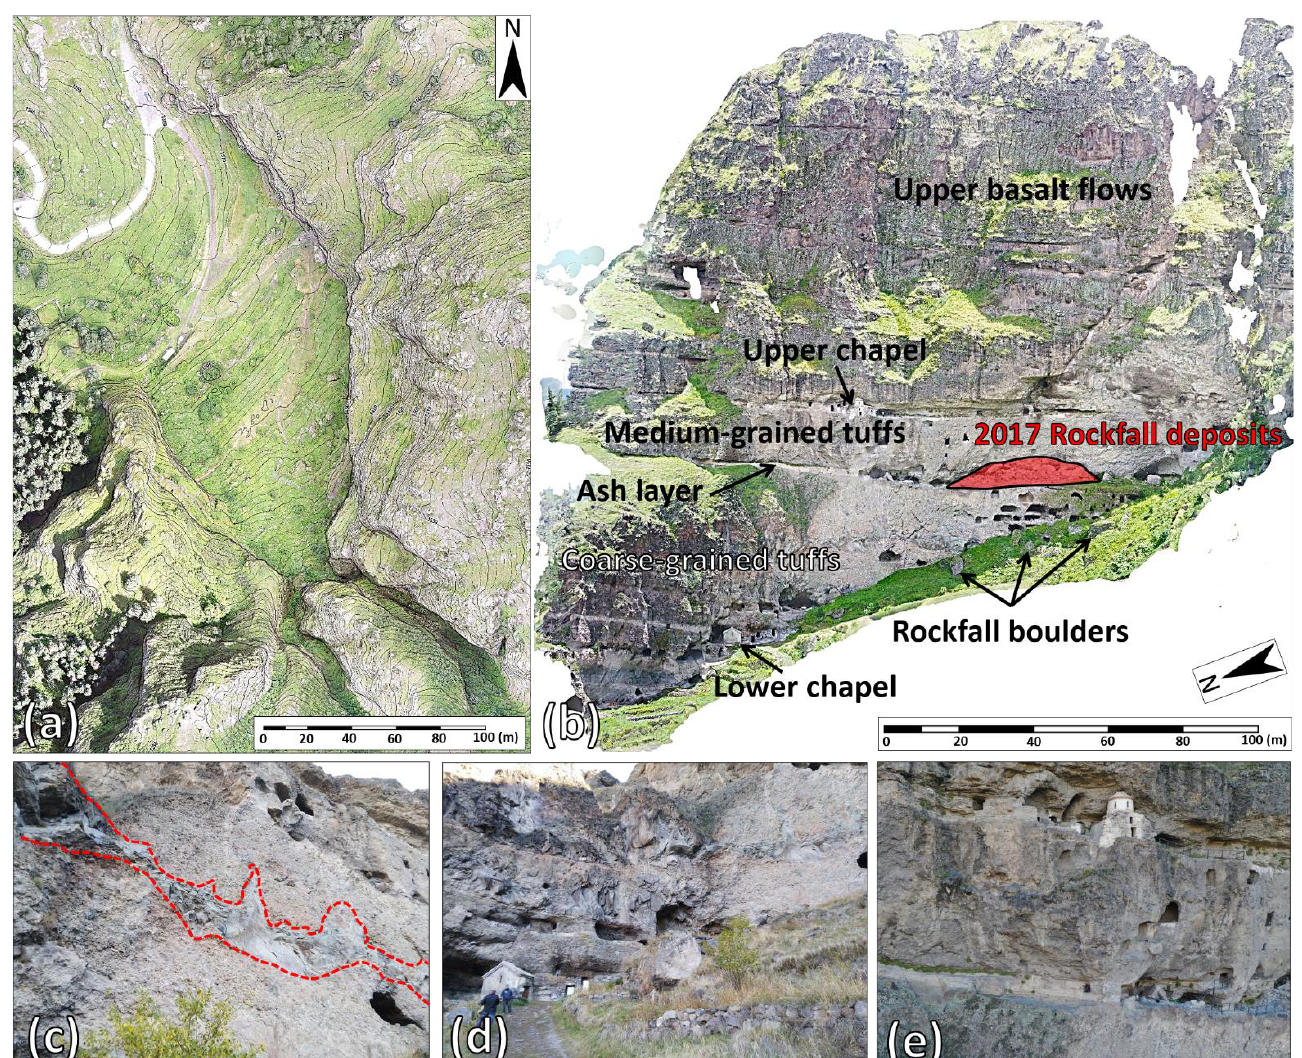
Figure 2. Vanis Kvabebi geological-geomorphological features: true color UAV-DP photogrammetric digital models: nadiral view ( a ); frontal view of the eastern main cliff of the monastery showing the outcropping lithologies of the Godertzi formation and the 2017 rock fall deposits ( b ); welded tuffs (dashed red line) ( c ); lower chapel with ancient rockfall boulder ( d ); upper chapel ( e ).